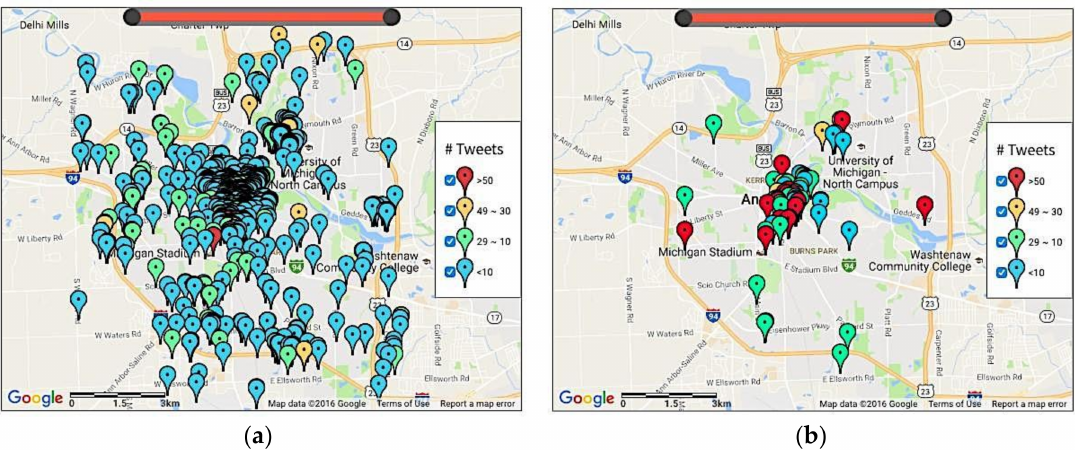
Figure 13. Effects of ST-DBSCAN parameters on clustering results in February 2014 in Ann Arbor: ( a ) without constraints of minUsers and minFw; and ( b ) with minUsers as 2 and minFw as 5.